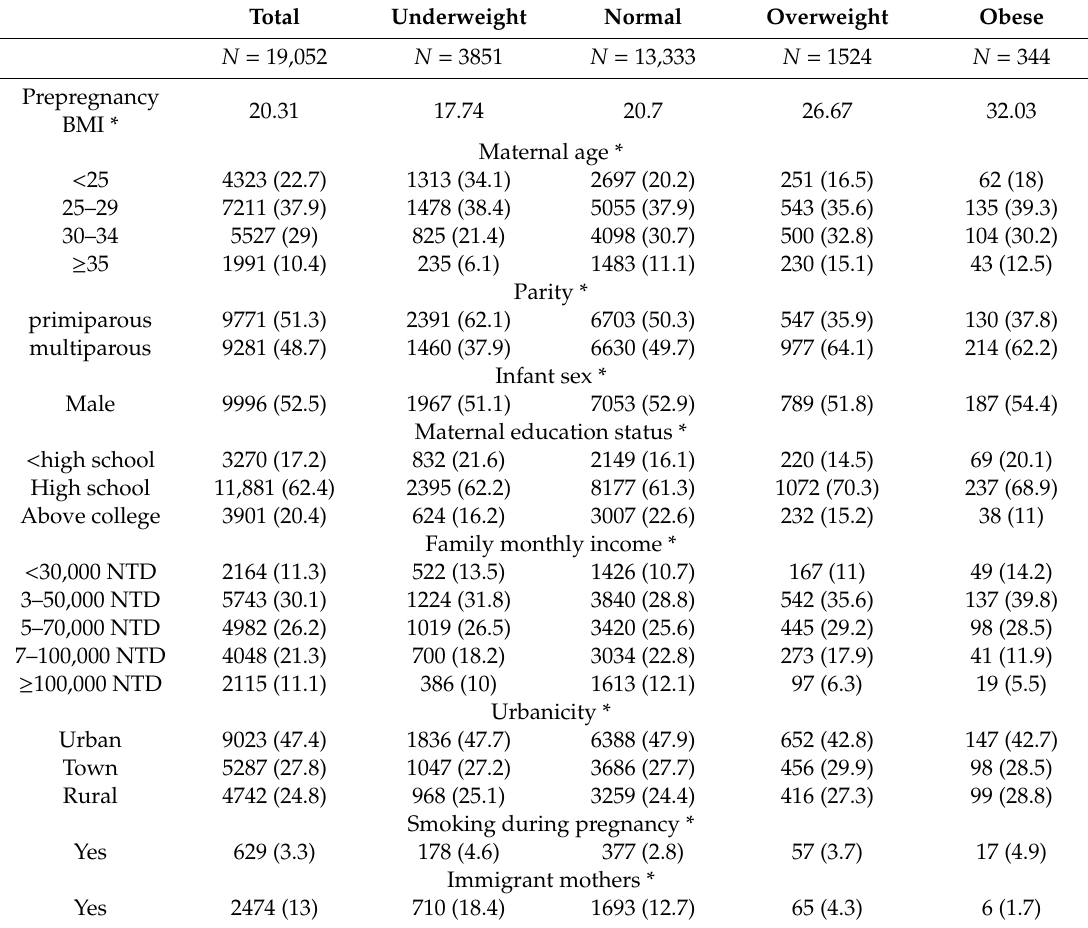
Table 1. Clinical characteristics of the study population.